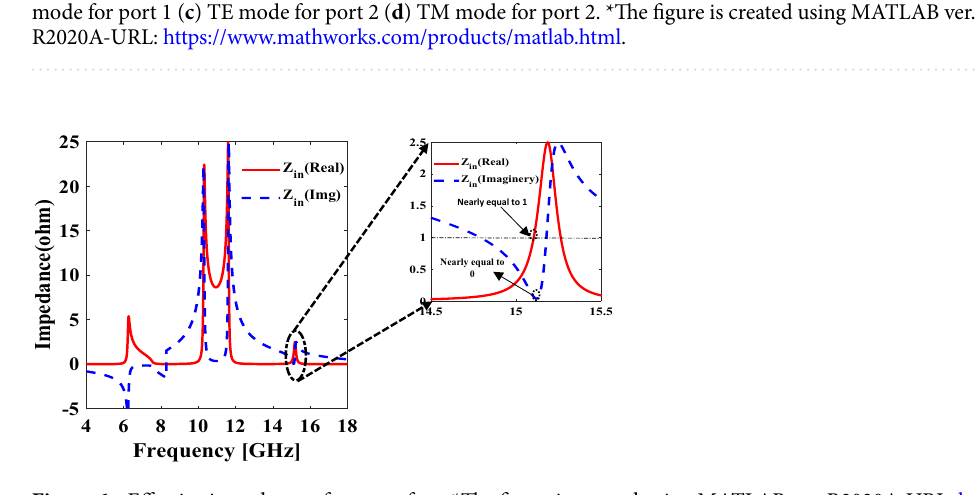
Figure 6. Effective impedance of metasurface. *The figure is created using MATLAB ver. R2020A-URL: https:// www. mathw orks. com/ produ cts/ matlab.